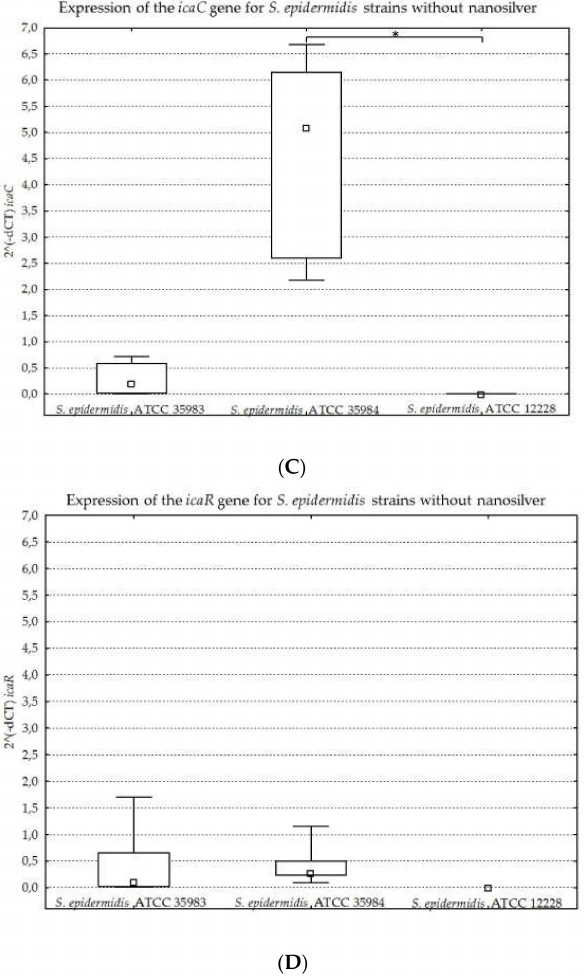
Figure 8. ( A – D ). Gene expression ( icaA , icaB , icaC , icaR ) depending on the strain of S. epidermidis without nanosilver, presented as medians and quartiles (Q1 and Q3). Statistical significance: * p < 0.05.